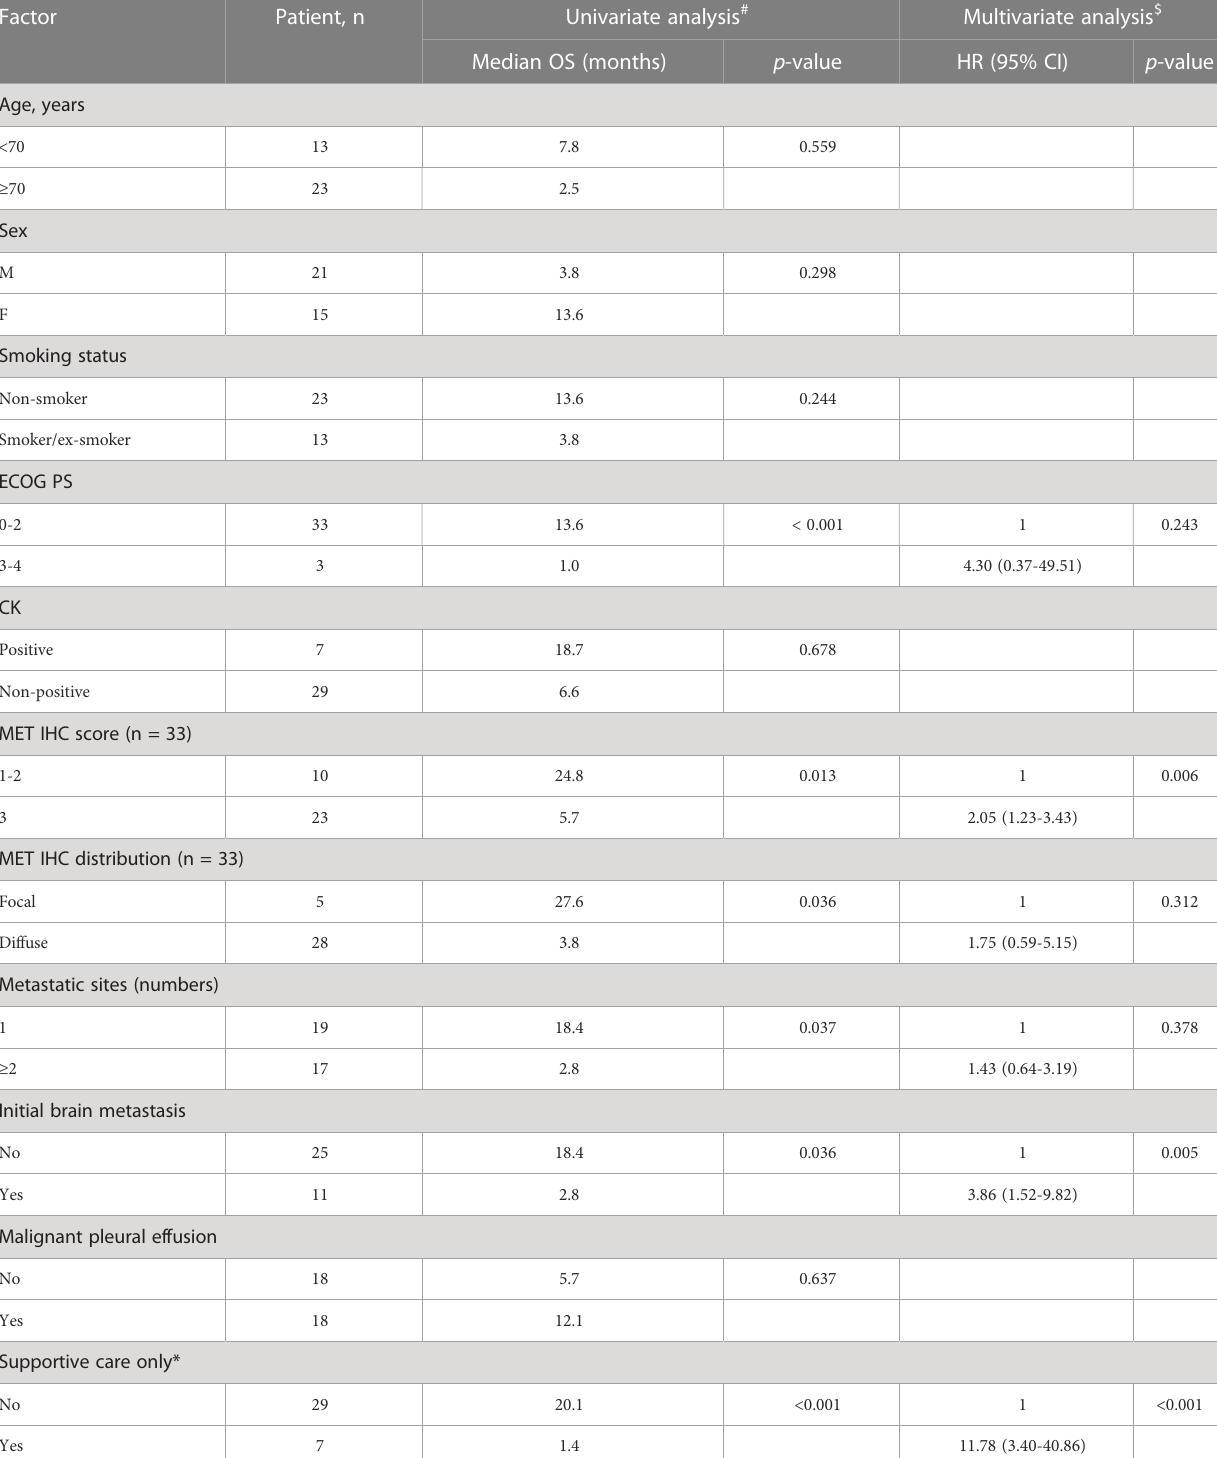
TABLE 2 Univariate and multivariate analyses of prognostic factors for overall survival in all patients with MET ex14-positive stage IV adenocarcinoma (n =